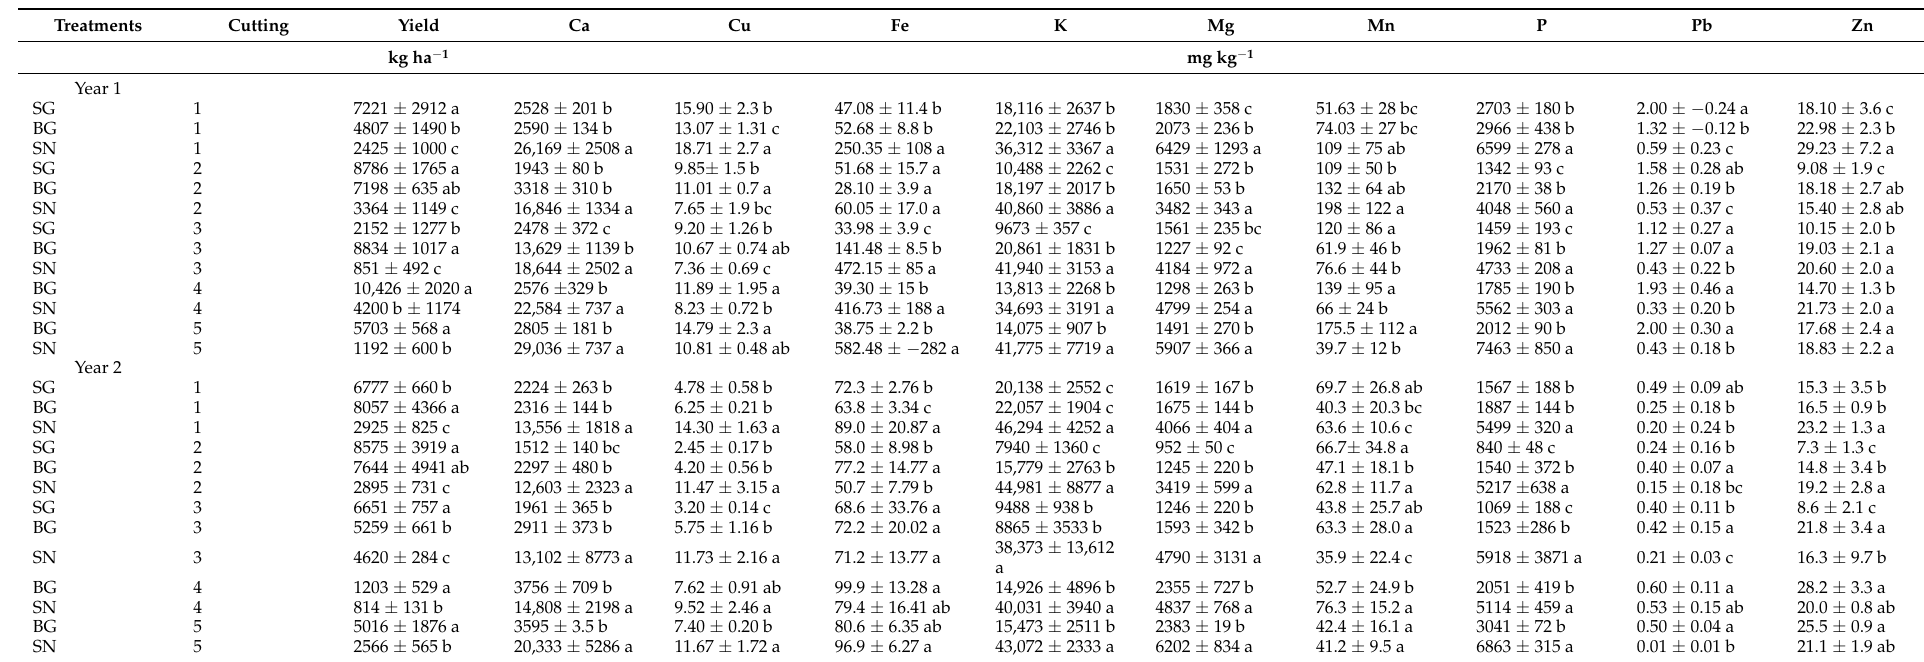
Table 3. Nutrient and metal concentrations in switchgrass (SG), bermudagrass (BG) and stinging nettle (SN) cuttings for the first and second